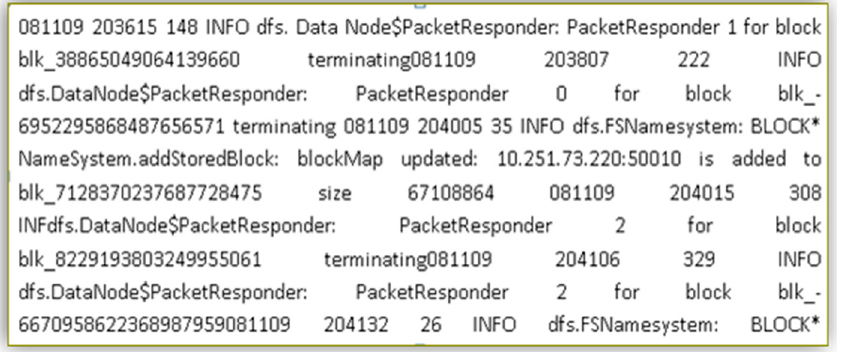
Figure 1 . Log data overview (BLOCK*: represents a block or bulk of events/activities/logs) Figure 1. Log data overview (BLOCK*: represents a block or bulk of